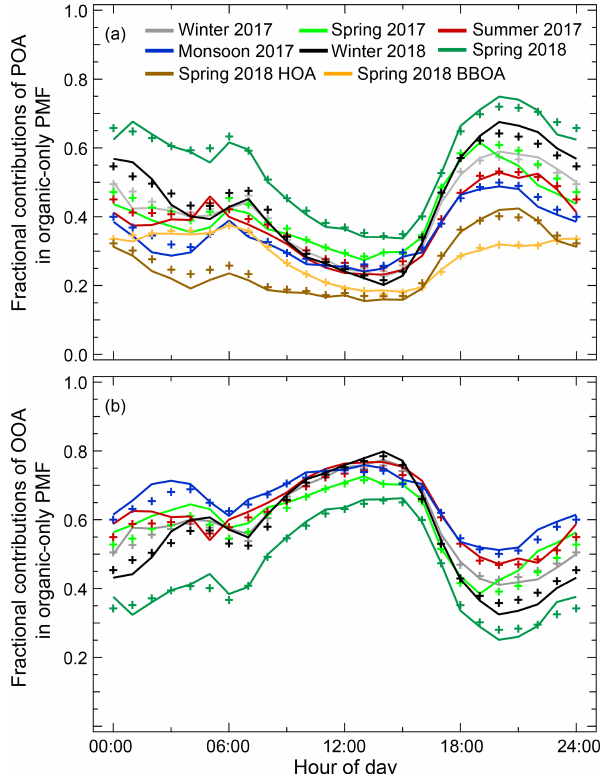
Figure 6. (a) Diurnal mean and median composition of POA from organic-only PMF analysis. Spring 2018 has a relatively higher POA fraction due to the unmixing of a separate BBOA profile. (b) Diurnal mean ( + ) and median (lines) fraction of OOA from organic-only PMF analysis in different seasons. Fractional contri- butions vary between 32% and 80% except spring 2018. This is likely due to the separation of BBOA mixed into the oxidized or- ganics in spring